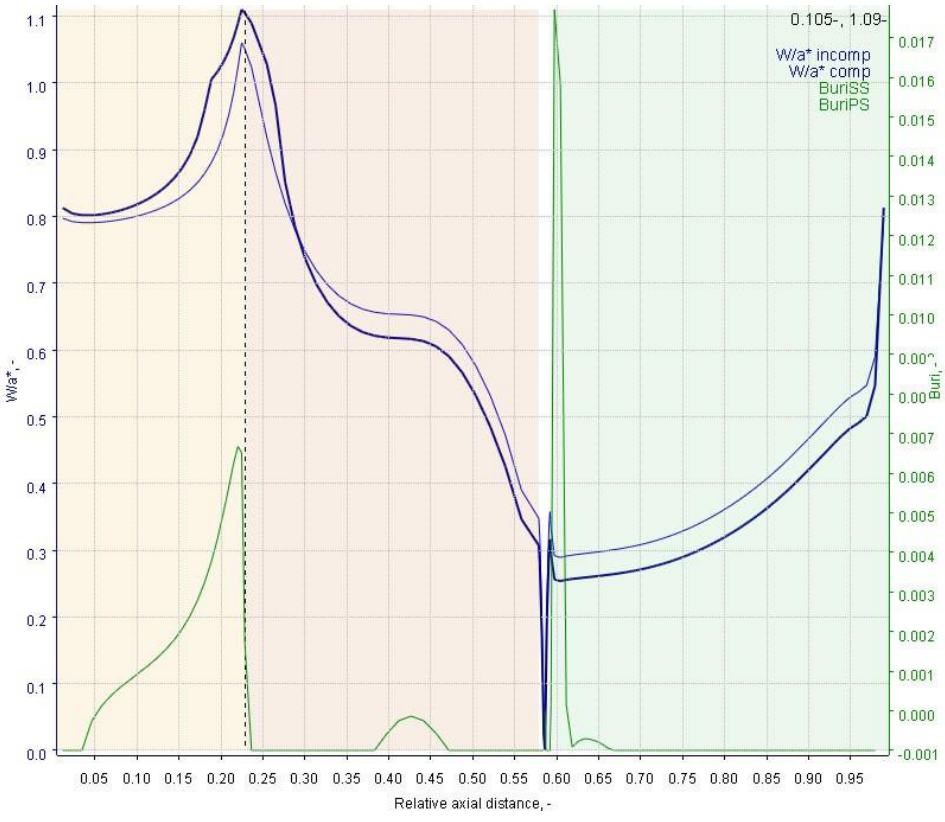
Figure 27. Mach number and Buri criterion plot for the optimized rotor airfoil.